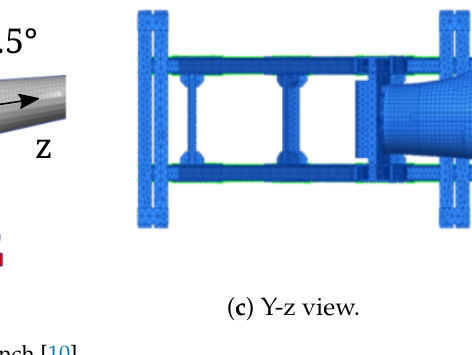
Figure 3. The root jig of the test bench